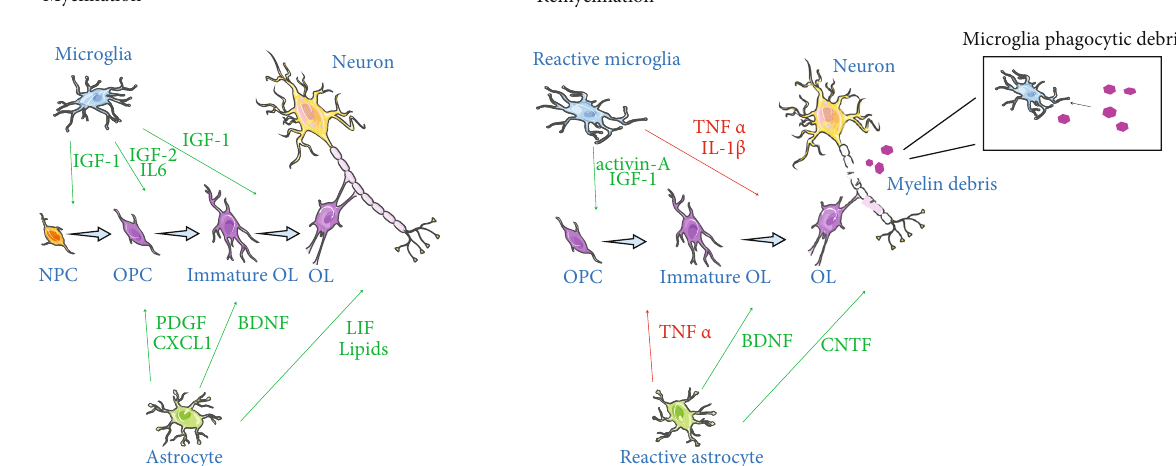
Figure 2: Myelination and remyelination of glial cells in the CNS. In the process of myelination, NPC matures into OPC, OPC proliferates and di ff erentiates into immature OL, which then forms myelin sheaths that wrap axons, and astrocyte and microglia release various molecules to control the development of OL and myelination. When the myelin sheath is damaged and repaired, OPC proliferates and di ff erentiates to supplement OL, astrocytes and microglia enter an activated state, and both exhibit dual activities, inducing harmful or bene fi cial e ff ects. In addition, microglia can swallow fragments of the myelin sheath. The green arrows indicate molecules exhibiting positive activity on oligodendrocyte lineage and myelin production, whereas the red arrows indicate molecules displaying inhibiting activity on oligodendrocyte lineage